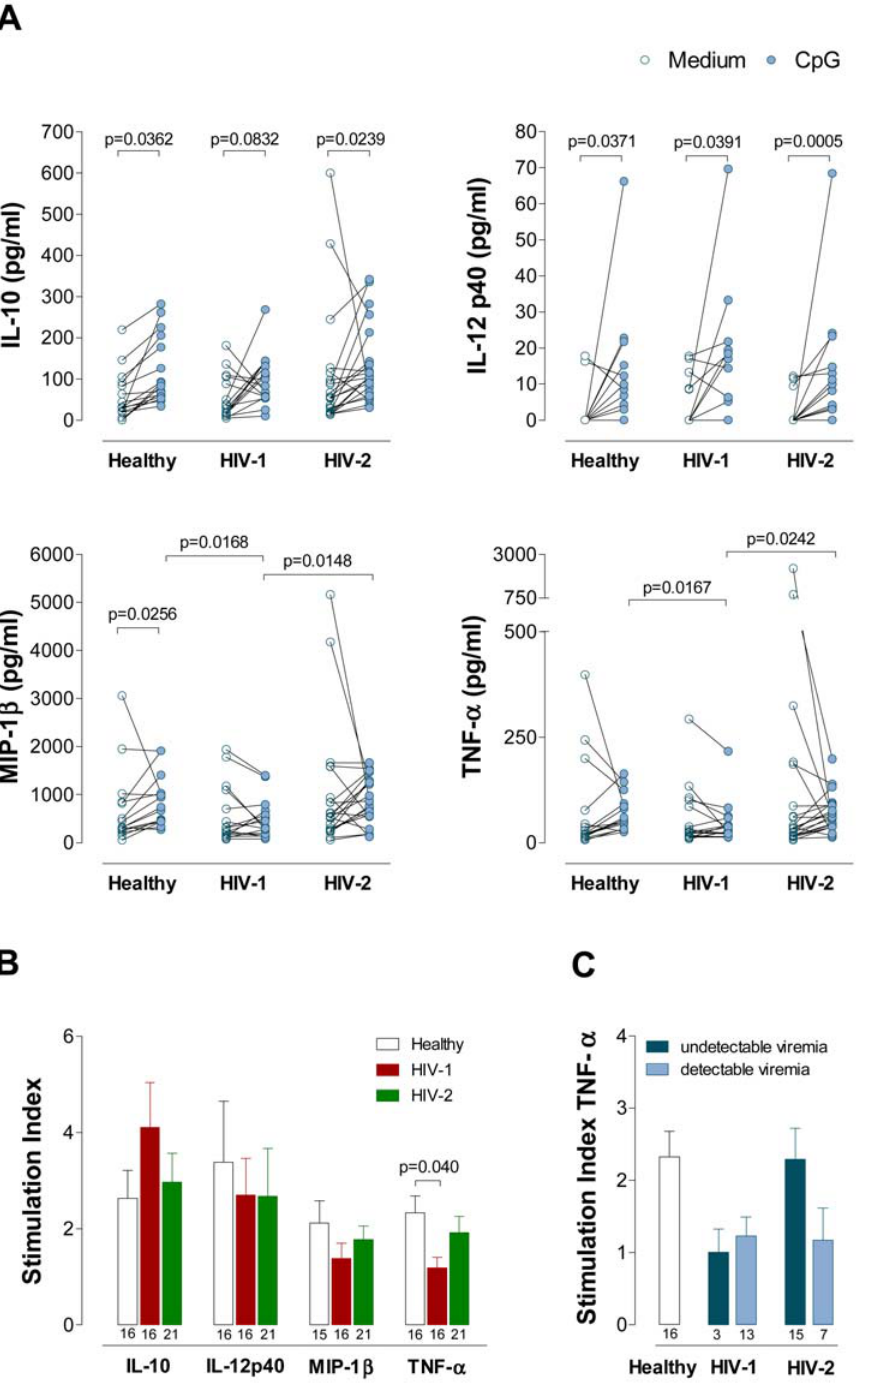
Figure 6. IL-10, IL-12p40, MIP-1 b and TNF- a levels upon CpG stimulation in Healthy, HIV-1 and HIV-2 cohorts. Freshly isolated PBMC were cultured in the absence or in the presence of CpG. After 22 hours, culture supernatants were harvested and analyzed for the secretion of IL-10, IL-12p40, MIP-1 b and TNF- a using the Luminex multiplex assay. ( A ) Cytokine levels. Each dot represents one individual. The levels observed in non- stimulated cultures (open symbols) are connected with those documented in the presence of CpG (closed symbols), and were compared using Wilcoxon test. ( B ) Stimulation indexes defined as ratio between the level of cytokine in the supernatant of the culture in the presence of CpG and in its absence (medium) in the three cohorts. ( C ) The HIV-2 and the HIV-1 cohorts were split according to the presence of detectable and undectable viremia and the stimulation indexes for TNF- a are shown. Bars represent mean 6 SEM. Numbers under the bars represent the total individuals analyzed. The subgroups of patients analyzed are representative of their respective patient population described in Table 1 with respect to CD4 counts and viral load. The Mann-Whitney test was used to compare the data of the HIV-2, HIV-1 and healthy cohorts, and the significant p values ( , 0.05) are shown.